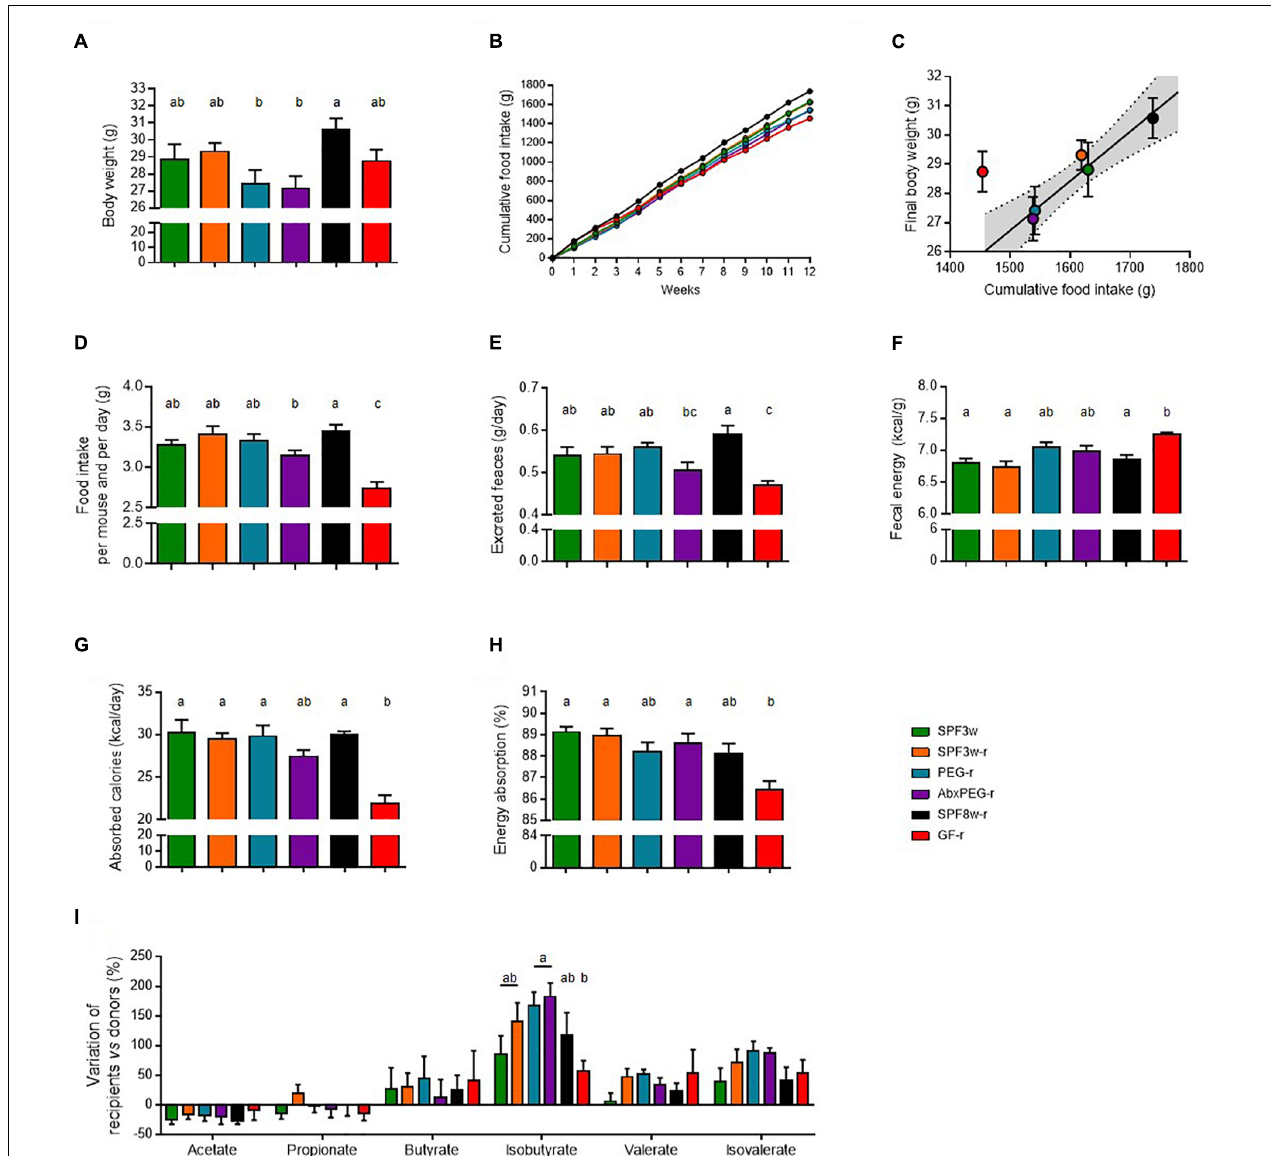
FIGURE 5 | Recipient age, microbiological status, and pre-treatment before microbiota transfer and influence on digestive physiology. (A) Body weight at the end of the experiment. (B) Cumulative food intake. (C) Food intake 10–12 weeks after fecal microbiota transfer. (D) Feces output per day and per mouse. (E) Fecal energy, expressed as calories per gram of dry feces. (F) Energy absorption, expressed as calories per day and per mouse. (G) Energy absorption capacity, expressed as the percentage of total energy ingested. (H) Cecum weight. (I) Variation of the concentration short-chain fatty acids in the cecal content of recipient mice in comparison with donor mice. Mice groups with different letters are significantly different (adjusted p <